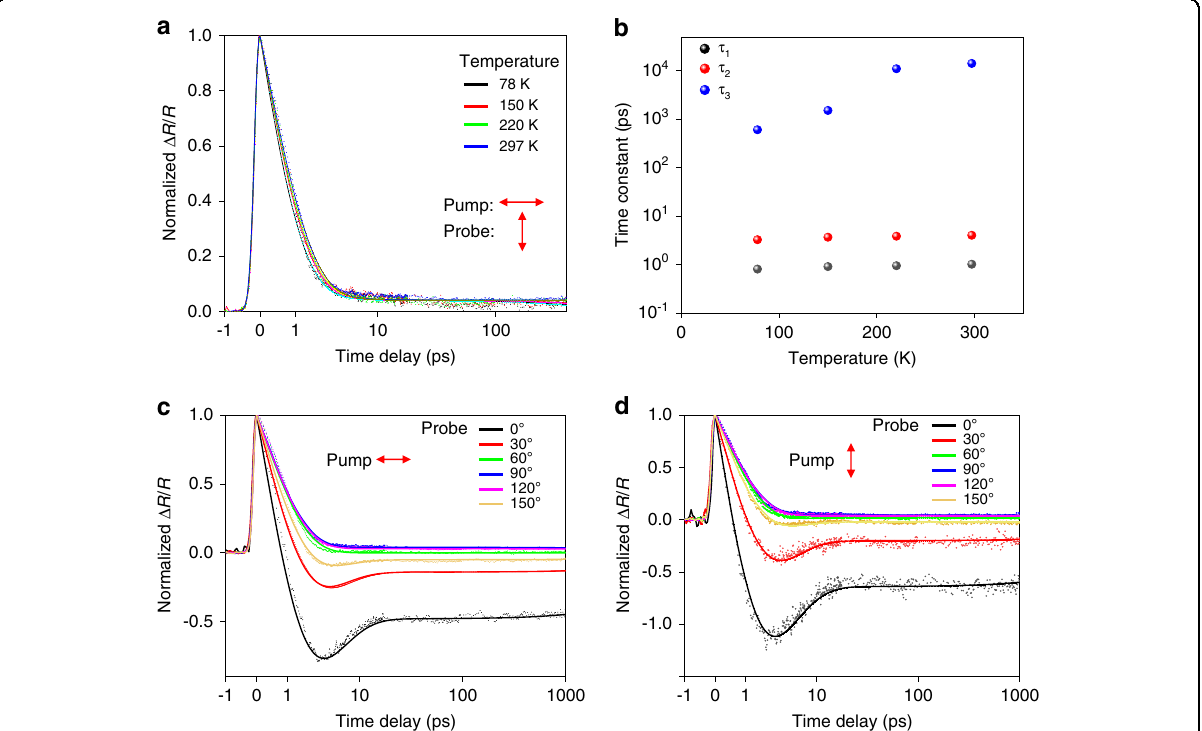
Fig. 2 Temperature and probe polarization dependence of transient dynamics. a The dependence of Δ R / R on temperature with cross-polarized pump and probe polarization (0° and 90° for pump and probe, respectively) with 300 μ W pump power. b The dependence of time constants on temperature. c , d Probe polarization dependence of normalized Δ R / R at room temperature with 0° ( c ) and 90° ( d ) pump polarization at room temperature. The pump power is 300 μ W. All curves are fi tted by tri-exponential function with the same decay constants τ 1 = 1.03 ± 0.01 ps, τ 2 = 3.95 ± 0.03 ps, and τ 3 = 14.0 ± 1.4